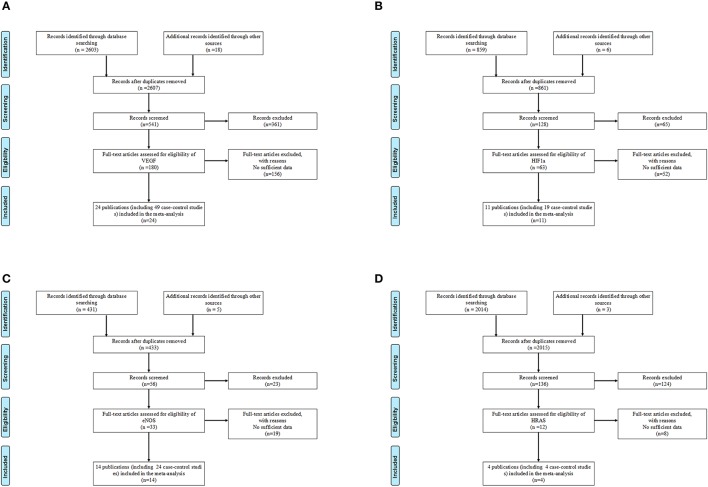
Flow chart of studies selection for VEGF/hypoxia/angiogenesis genes polymorphisms. (A) Flow chart of studies selection for VEGF genes polymorphisms. (B) Flow chart of studies selection for HIF1α genes polymorphisms. (C) Flow chart of studies selection for eNOS genes polymorphisms. (D) Flow chart of studies selection for HRAS genes polymorphisms.